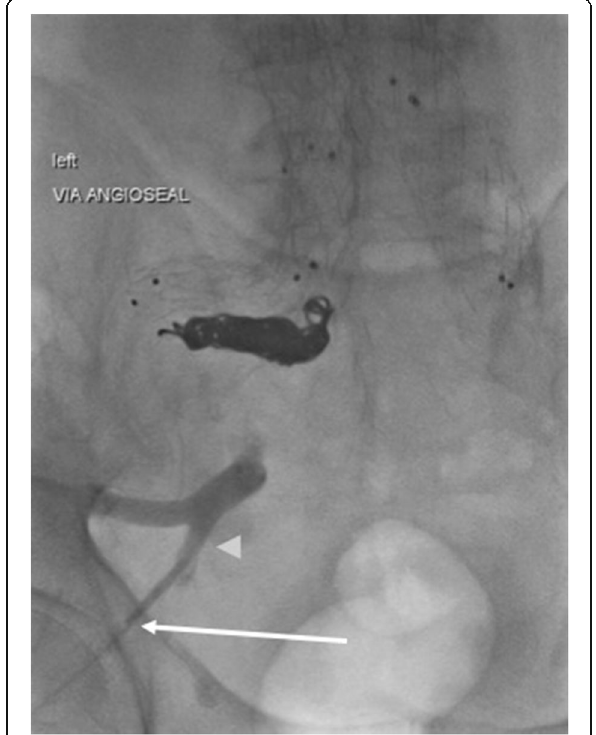
Fig. 5 Angiogram via 4Fr dilator inserted through AngioSeal sheath (arrow) to visualise angioseal sheath tip